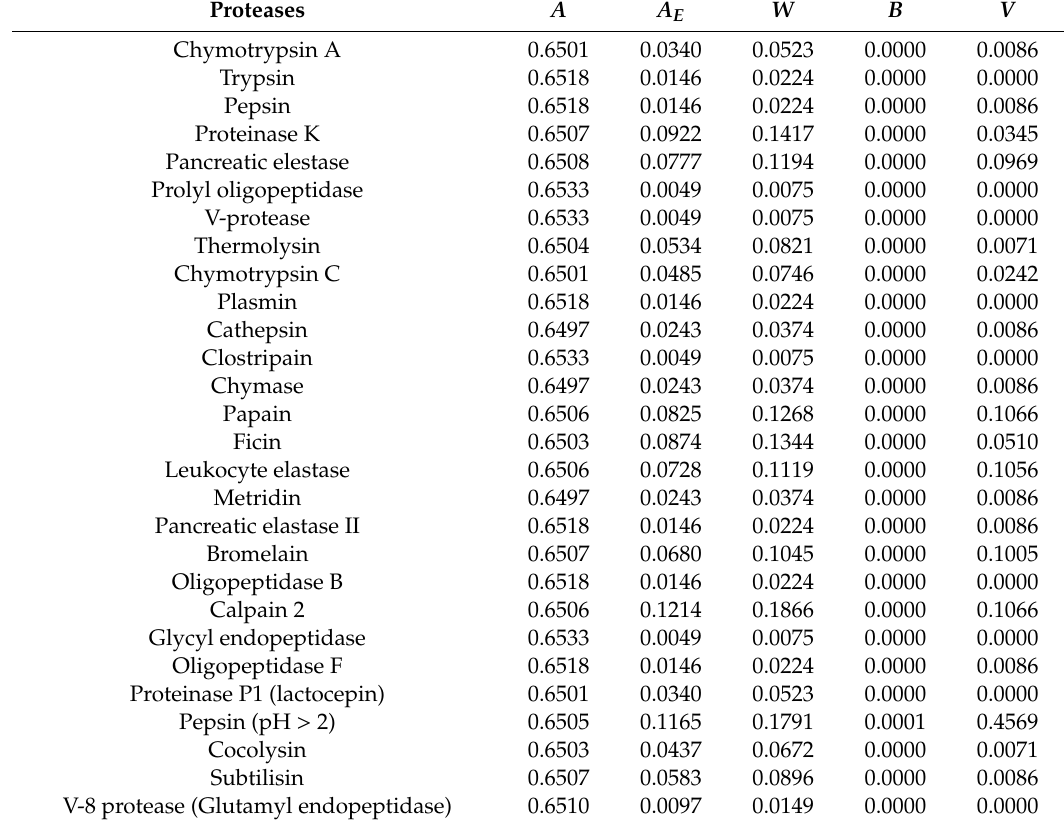
Table 3. The values of parameters describing the predicted e ffi ciency of release of bioactive dipeptidyl peptidase IV inhibitor fragment from Halophila stipulacea -RubisCO by proteases.